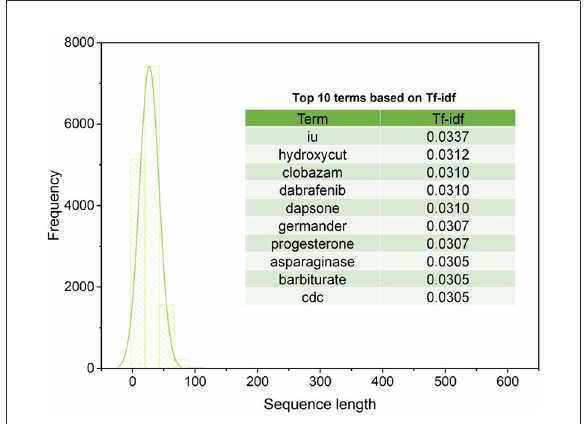
FIGURE2 The distribution of sequence length and the top 10 terms based on Tf-idf values.